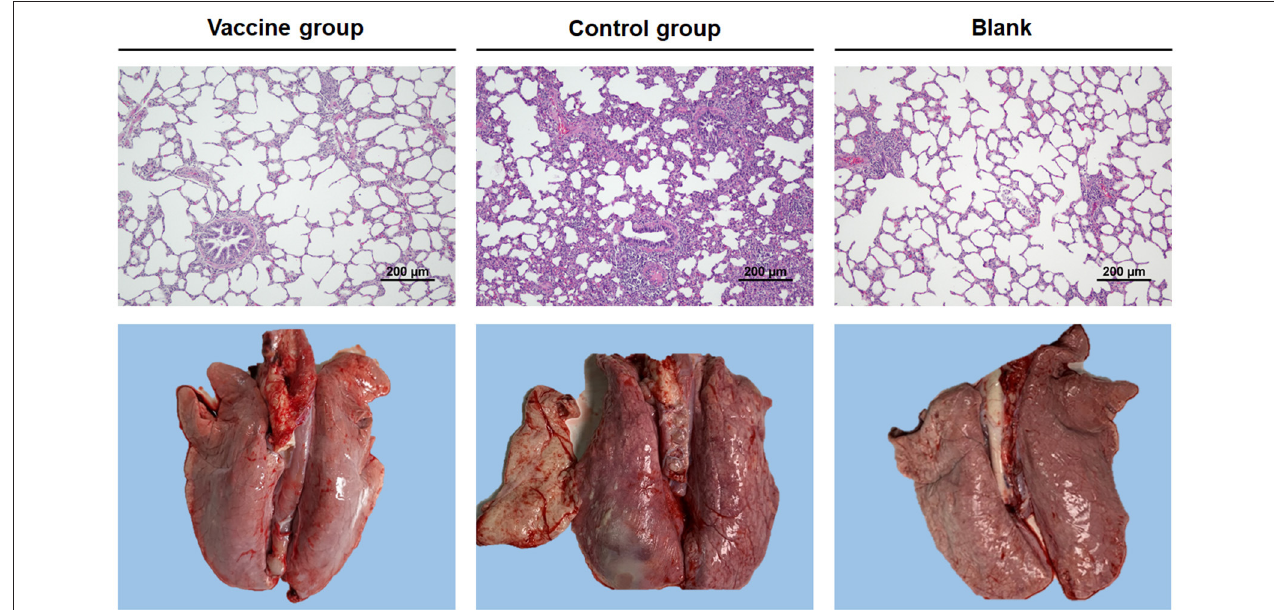
FIGURE 6 | Representative photographs of gross and microscopic lung injury. Pigs were vaccinated two times with bac-subunits (vaccine group) and PBS (control group), respectively, and then challenged with A. pleuropneumoniae strain HB01. Blank is the lung of a normal pig. Original magnifications ×